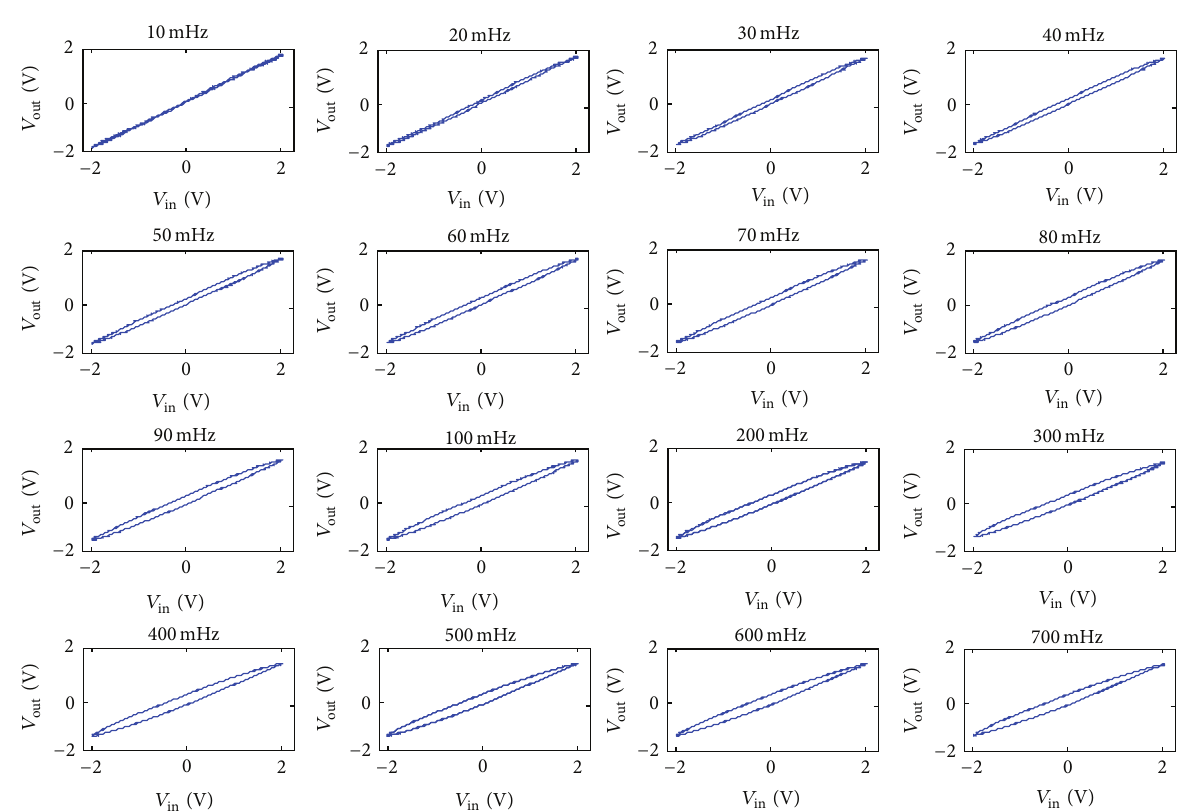
Figure 5: Lissajous curves on measured input ( V in ) and output ( V out ) voltages in the frequency range between 10mHz and 700 mHz for the device IPMC AbsT- 5 h